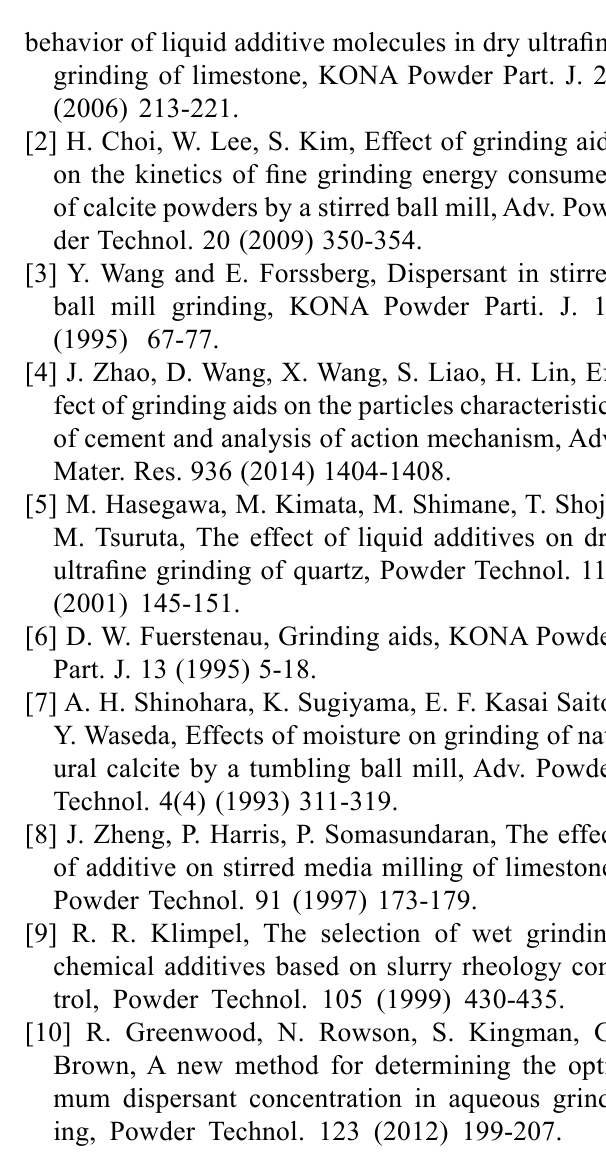
Fig. 3. ∆Ry-value of the products before and after milling with grinding